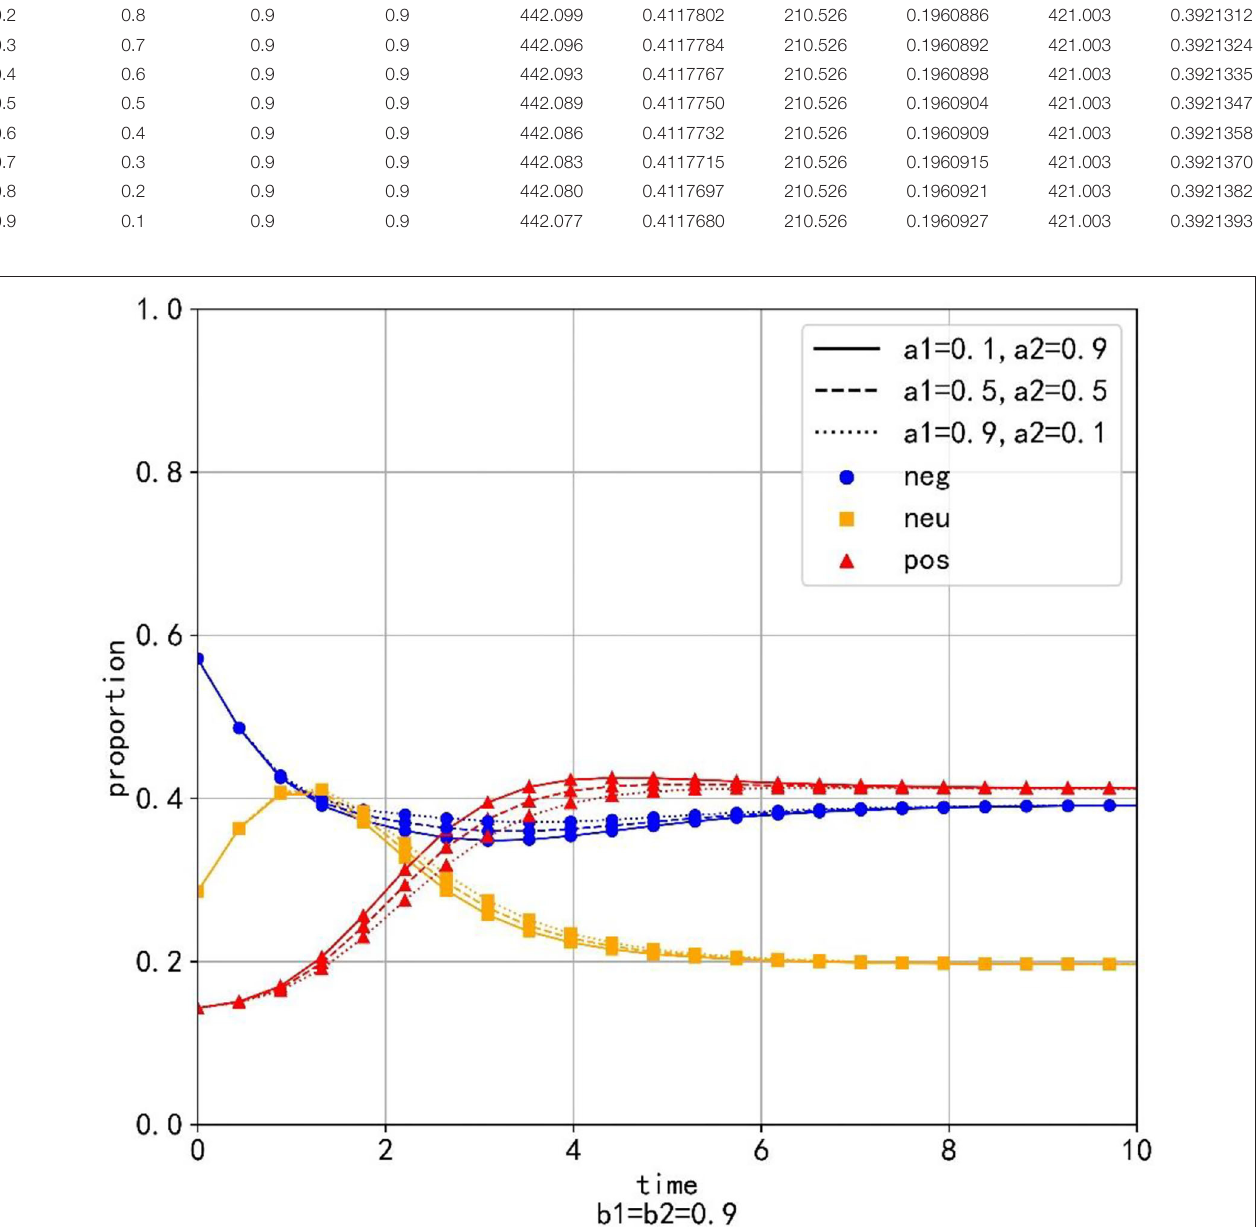
FIGURE 4 | The evolution trend of the proportion of three emotions under the condition of changing the transfer coefficient.